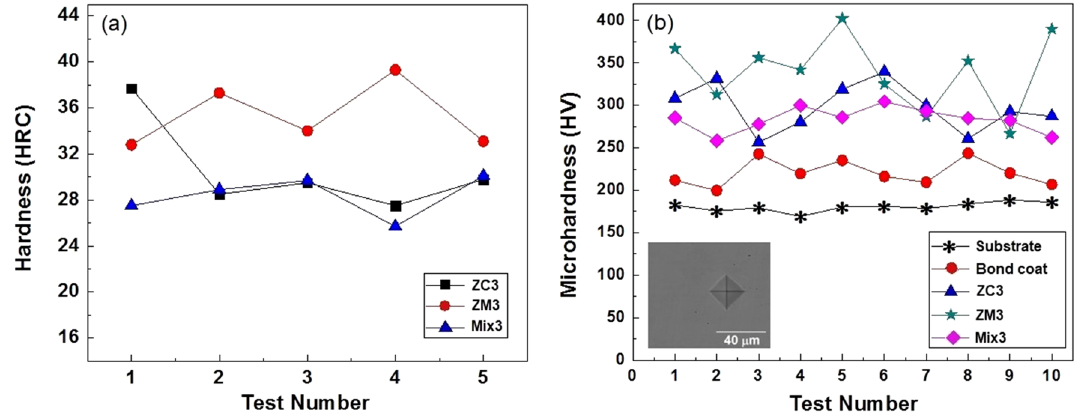
Figure 10. ( a ) Rockwell hardness carried out on the surfaces of the ZC3, ZM3, and Mix3 samples coated at 300 μm thickness and plasma spraying current of 700 A. ( b ) Vickers microhardness variation on the cross- section of the substrate, bond coat, and top coats of ZC3, ZM3, and Mix3 samples (ten indentation per sample) coated at 300 μm thickness and plasma current of 700 A. The inset is a SEM image show the Vickers indent on the cross-section of the substrate under a 500-g